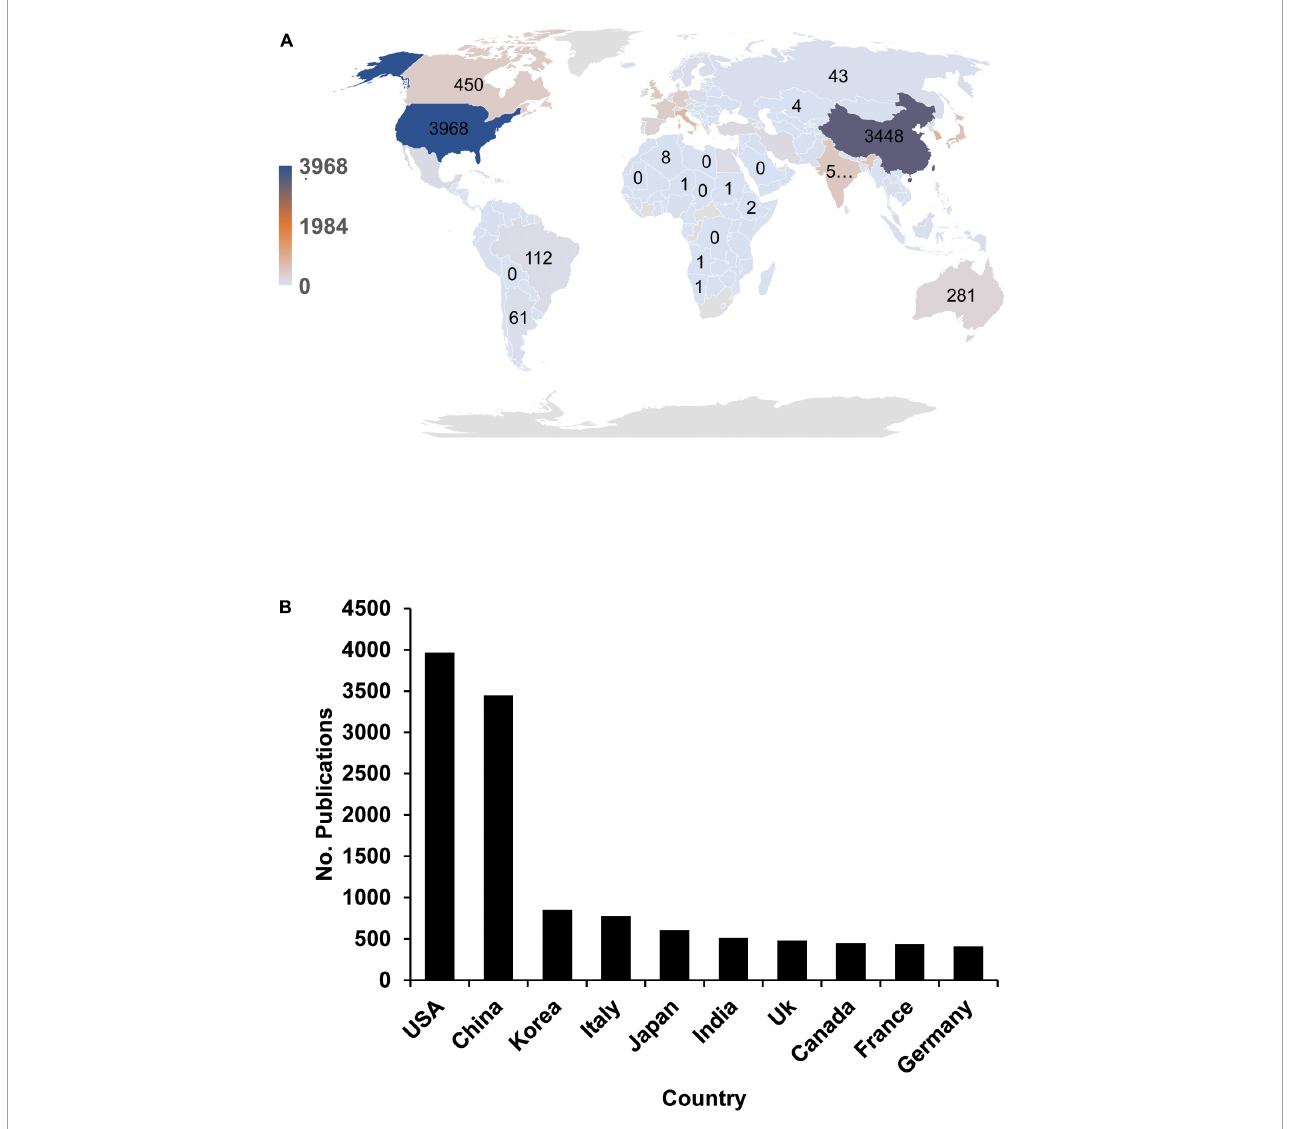
FIGURE3 Global triple-negative breast cancer (TNBC) research differs significantly between regions. (A) The global distribution of TNBC publications in the recent 17 years is shown. We extracted the country information based on the first publication’s affiliation. (B) Top 10 countries with the highest publication numbers in TNBC